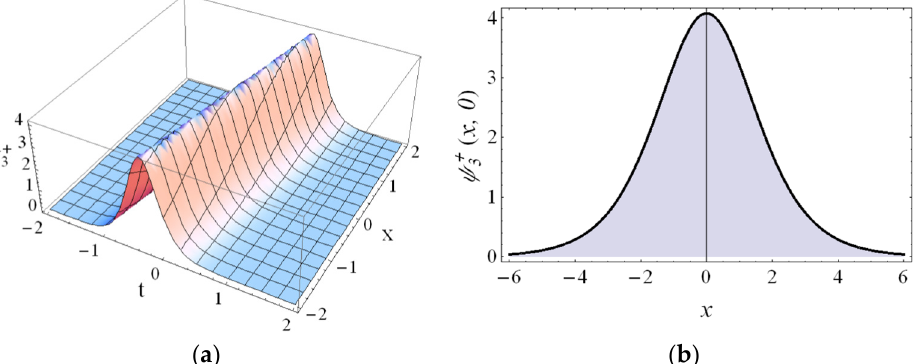
Figure 3. The dynamic characteristics of ψ + for t = 0.